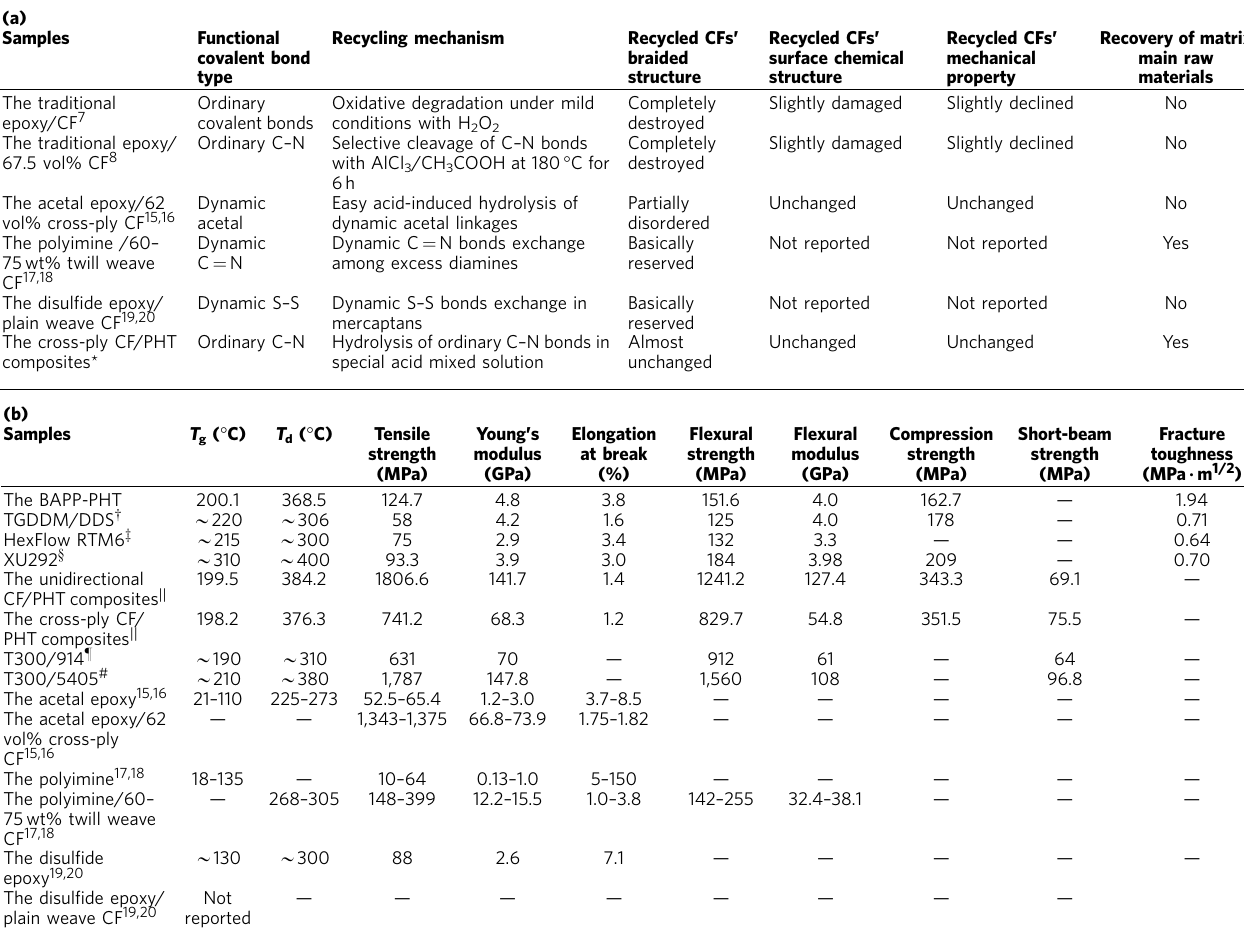
Table 1 | Performance parameters of the BAPP-PHT and the CF/PHT composites and a comparison with other analogous resins and composites. (a) Recyclability; (b) Thermal stability and mechanical property.